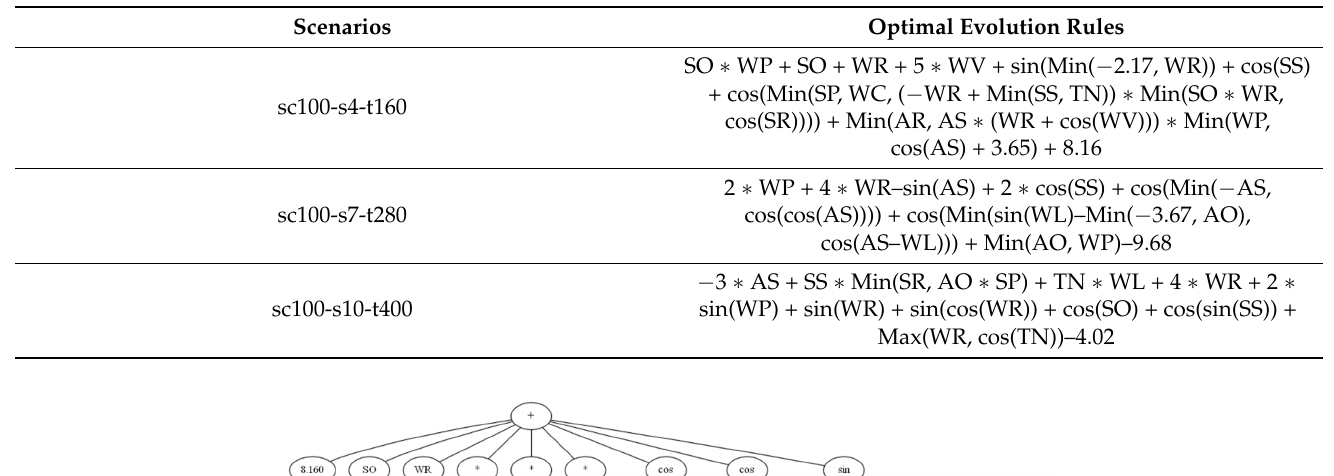
Figure 8. The GEP evolutionary process.